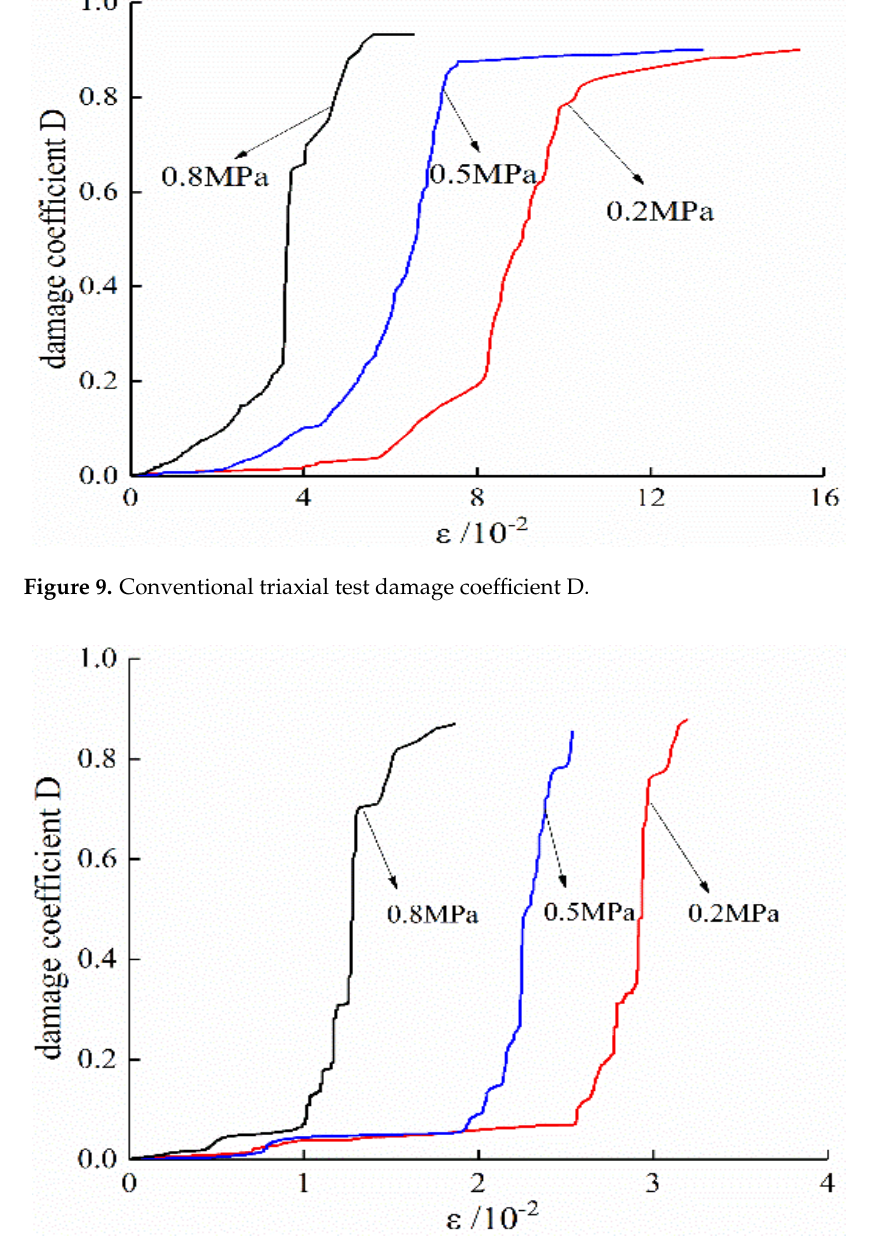
( b ) ( c ) Figure 11. Calculated stress and measured stress for the conventional triaxial test. ( a ) Gas pressure of 0.2 MPa. ( b ) Gas pressure of 0.5 MPa. ( c ) Gas pressure of 0.8 MPa.